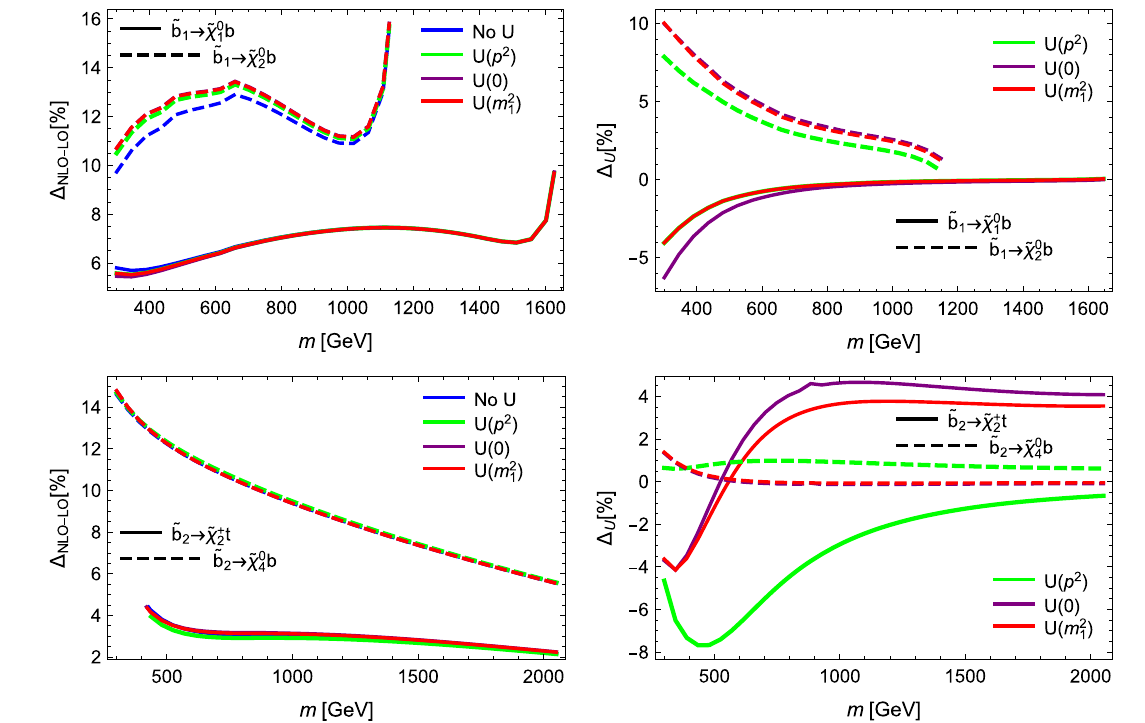
Fig. 9 Impact of the external U -factors for sbottom decays. On the left side, we show the relative NLO correction when equal U -factors are applied at LO and NLO . On the right side, we show the relative